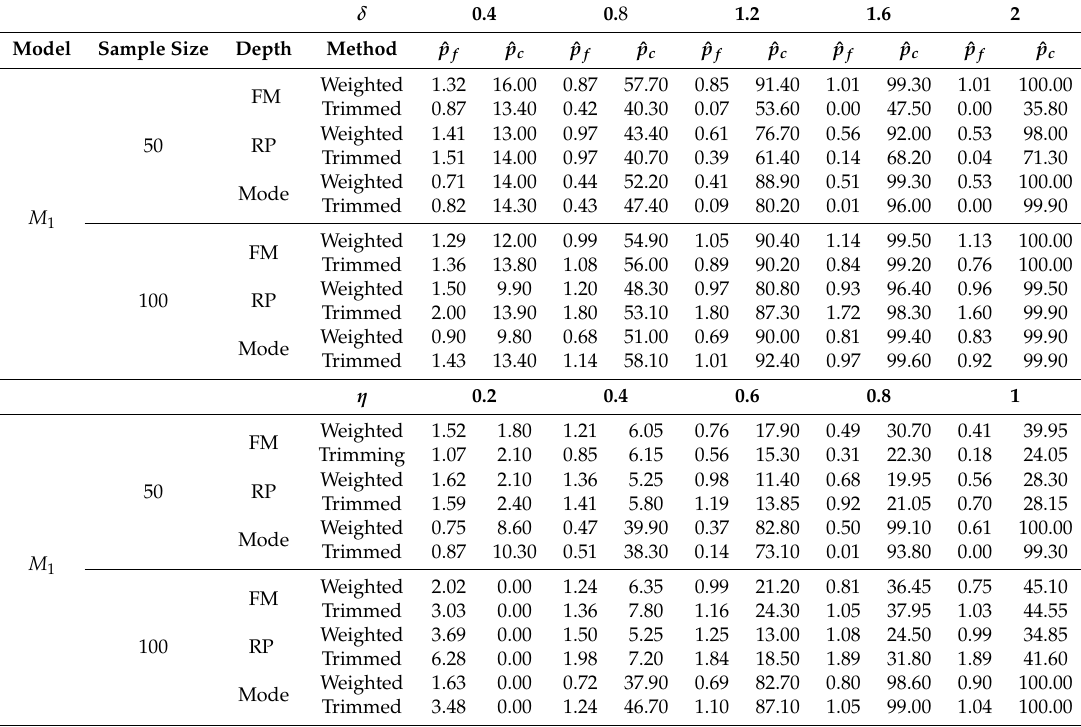
Table 6. Empirical values of ˆ p f and ˆ p c , with ρ = 0.7 (assuming dependence between